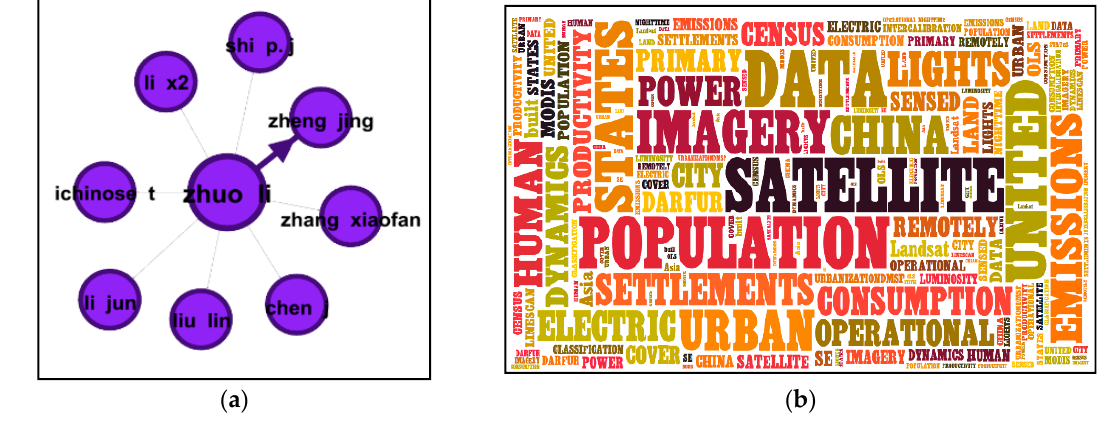
Figure 10. Zhuo, L. research community: ( a ) co-author network; ( b ) related topics.